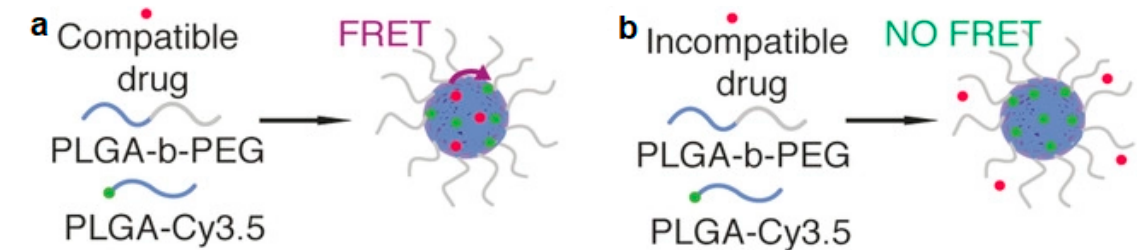
Figure 4. Real-time monitoring of drug loading and FRET mechanism of PLGA-b-PEG polymer NPs using ( a ) a hydrophobic Cy5-OLA model drug and ( b ) a hydrophilic sulfo-Cy5 model drug. Reproduced with permission from ref. [25]. Copyright 2017, Wiley-VCH Verlag GmbH & Co. KGaA, Weinheim, Germany.